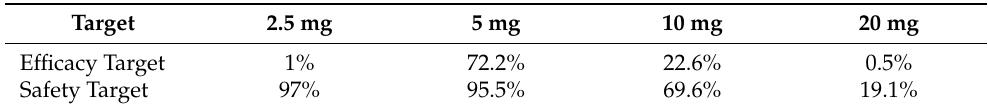
Figure 6. Simulations of the standard treatments of NEB. Output distributions that represent the variability between individuals with visual cues of the concentration prediction intervals. The visual cues demonstrating the efficacy (1–2 ng/mL) and safety (0.5 ng/mL) are displayed as red lines. Table 6. Values of the efficacy and safety target for standard treatments for cardiac patients and recommended treatment for patients with renal